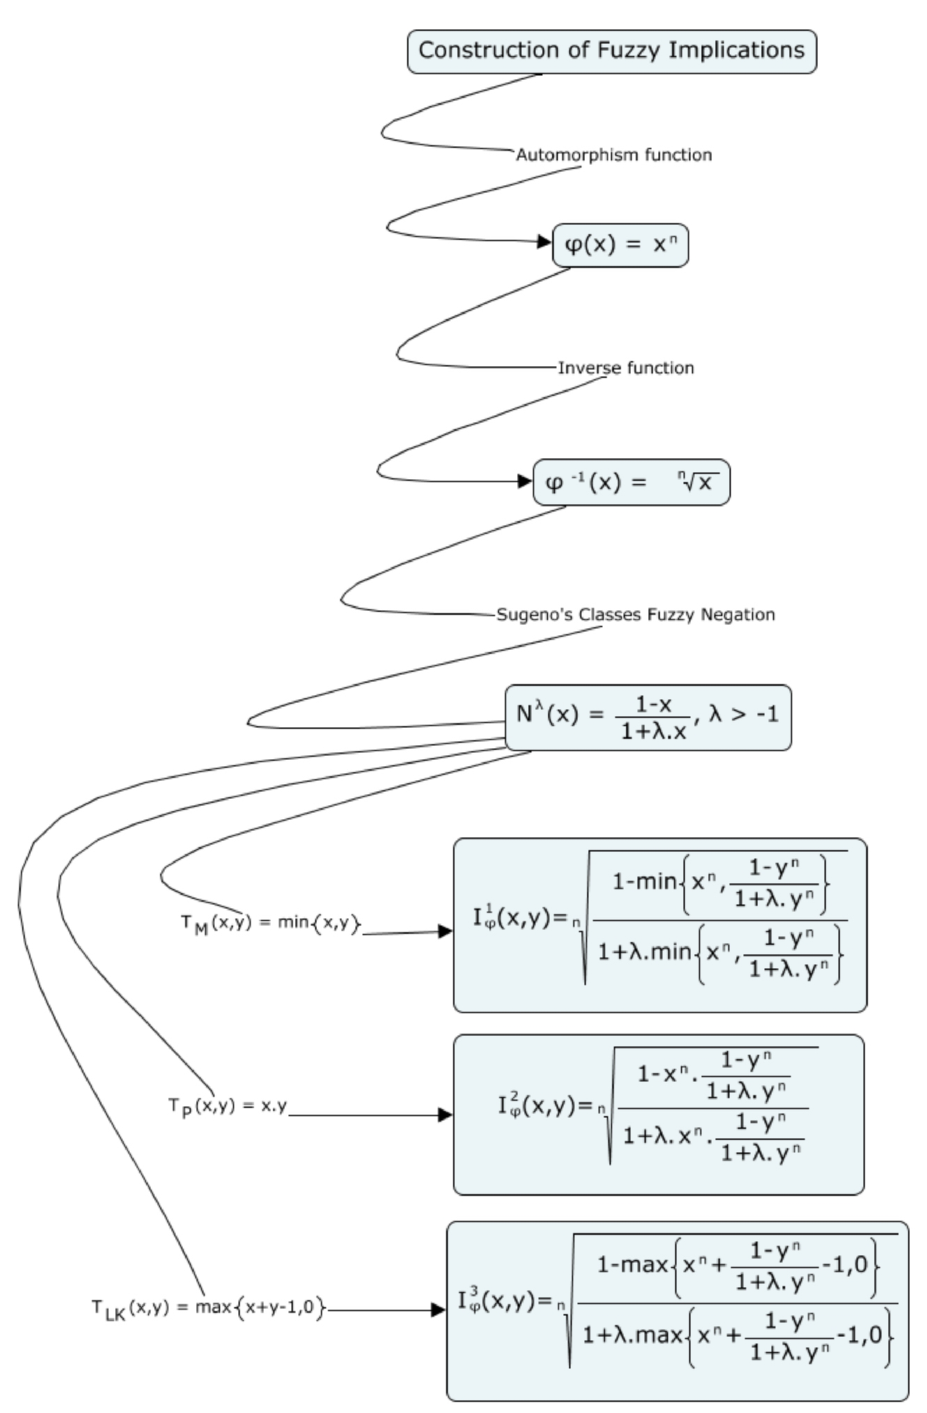
Figure 4. Graph of the construction of fuzzy implications using ( ϕ ( x ) = x n , N λ ( x ) = 1 − x